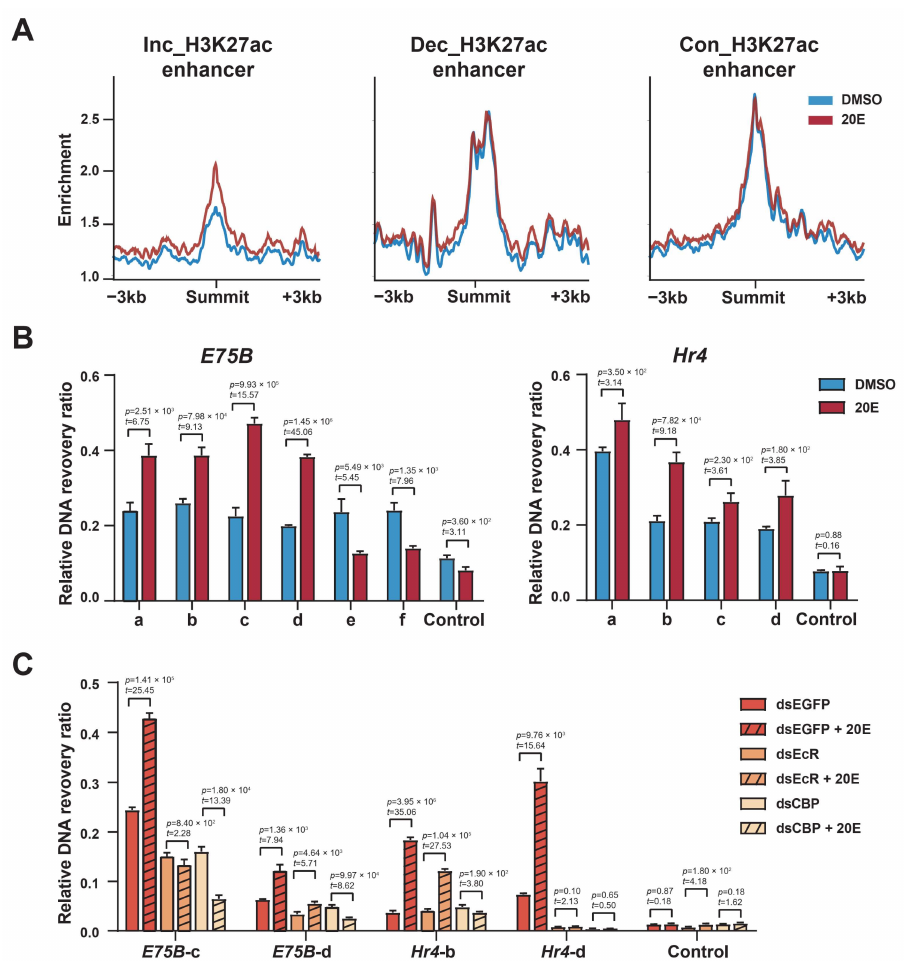
Figure 7. Ecdysone signaling can target inaccessible chromatin. ( A ) FAIRE-seq read density profiles ± 3 kb around the summits of enhancers from the three enhancer categories before and after 20E treatment (blue and orange, respectively). Inc_H3K27ac, Dec_H3K27ac, and Con_H3K27ac: increas- ing, decreasing, and constant H3K27 acetylation, respectively. ( B ) Nucleosome density assayed via FAIRE-qPCR in BmE cells treated with DMSO or 20E. The relative DNA recovery ratio between free versus total DNA was calculated and plotted. DNA was quantified using primers designed to amplify the putative regulatory elements of E75B and Hr4 gene loci. Error bars: standard errors of the mean (SEM) from three biological replicates measured in duplicate. Student’s t -test (df = 4). ( C ) Nucleosome density assayed via FAIRE-qPCR in BmE cells first treated with dsRNA against EGFP, EcR, or CBP, then either left untreated or exposed to 20E for 12 h. The relative DNA recovery ratio between free versus total DNA was calculated and plotted. DNA was quantified using primers designed to amplify the putative regulatory elements of E75B and Hr4 gene loci, as shown in Figure 1C,E. Error bars: standard error of the mean (SEM) from three biological replicates measured in duplicate. Student’s t -test (df =